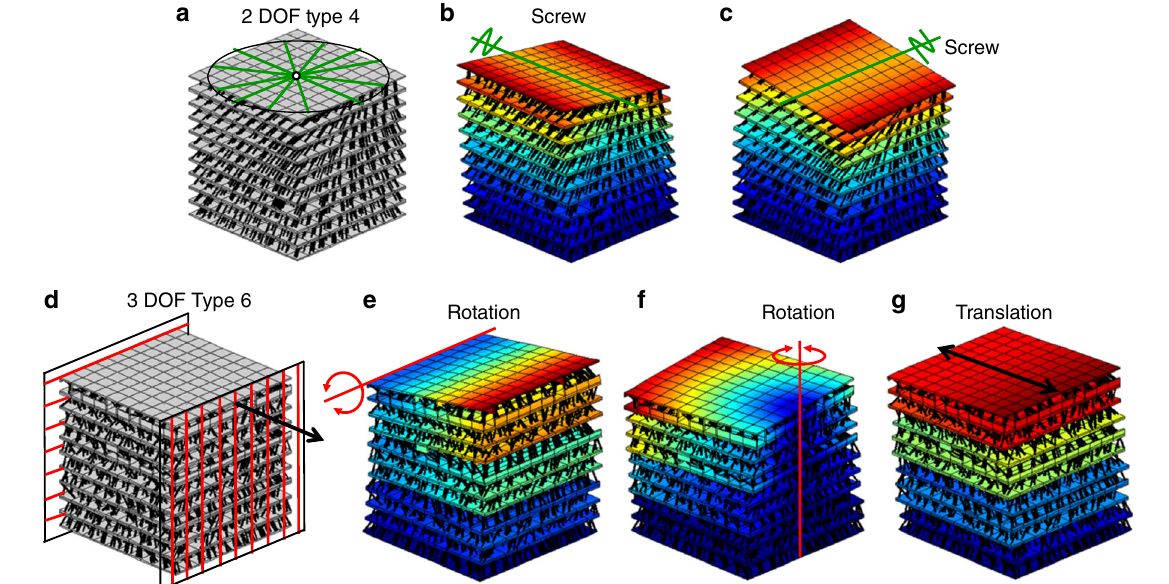
Fig. 8 Less intuitive designs generated by the automated tool. a A design that achieves, b , c two intersecting screw degrees of freedom (DOFs) with the same pitch. d A different design that achieves, e , f two orthogonally skew rotational DOFs and, g an orthogonal translational DOF